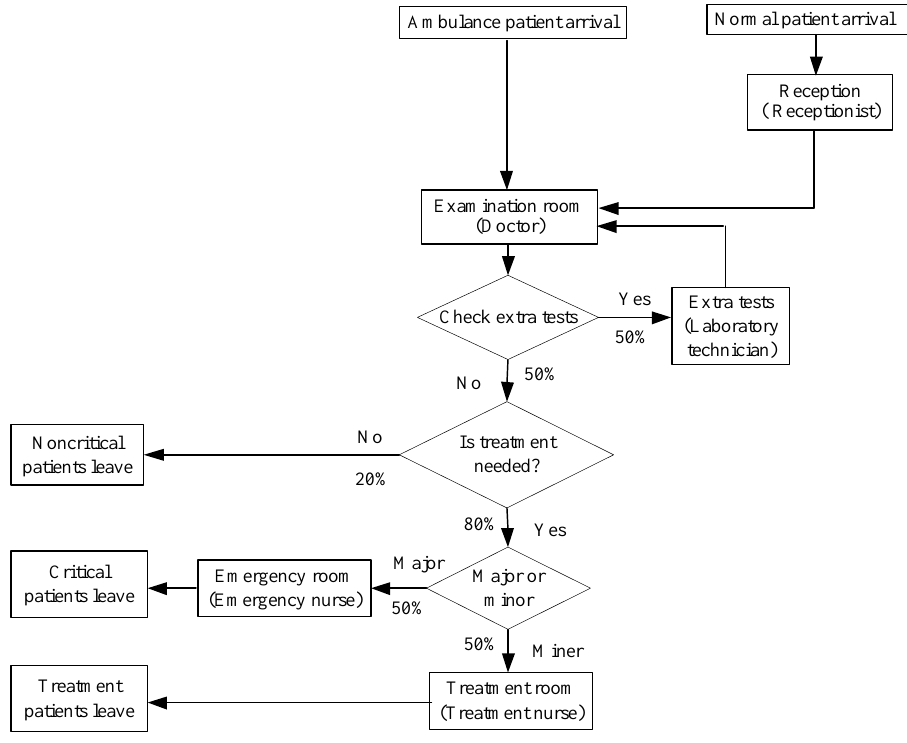
Figure 3. Patient flow process of an emergency department.